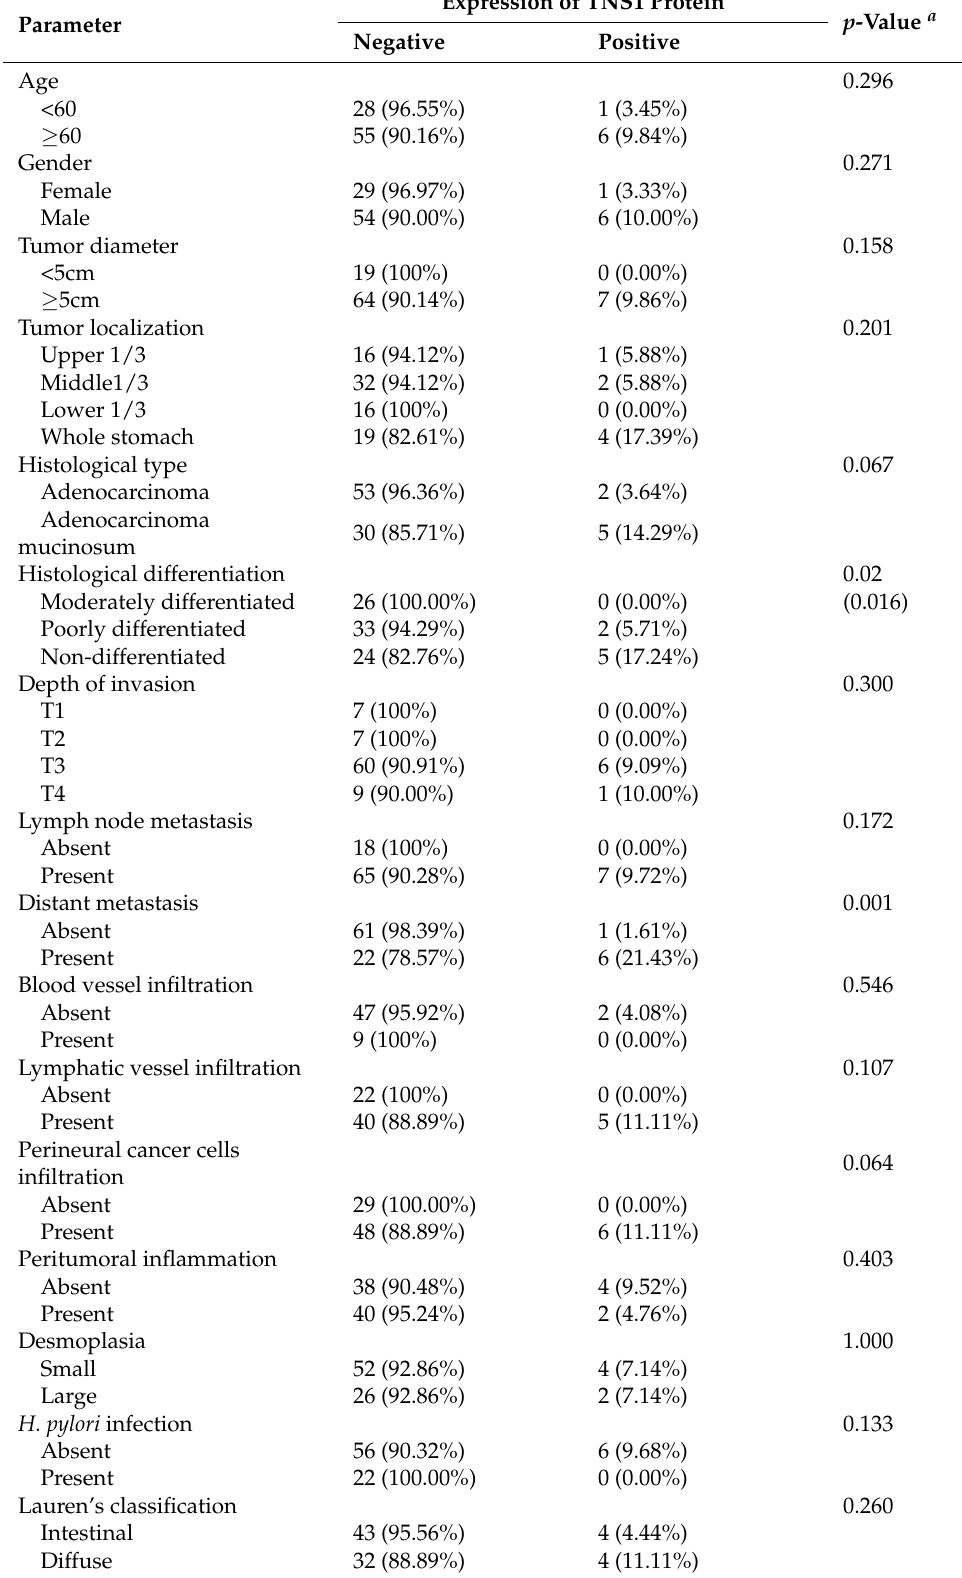
Table 2. Correlation between TNS1 protein expression level in gastric cancer and clinicopathologi- cal